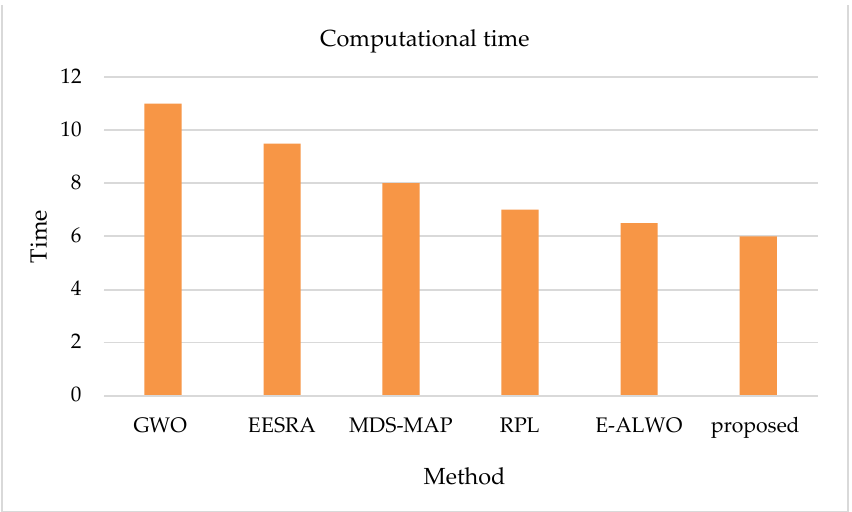
Figure 7. Computational time comparison with other studies.